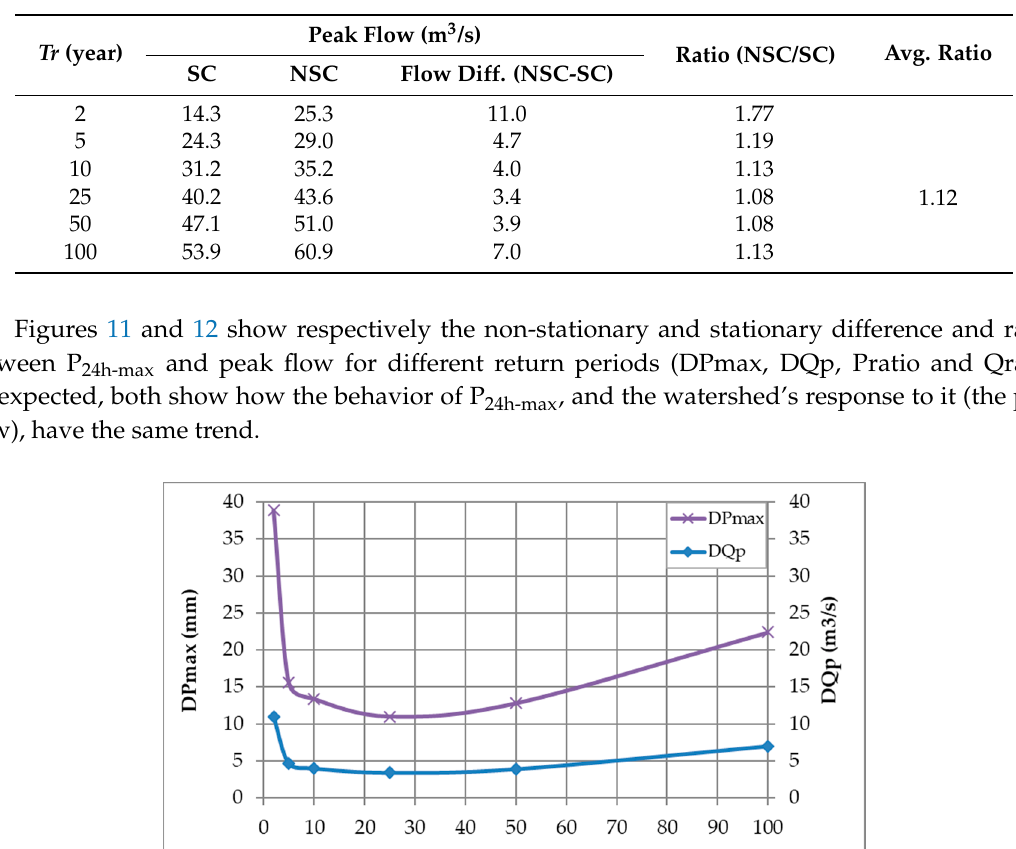
Table 11. Peak flow values comparison.